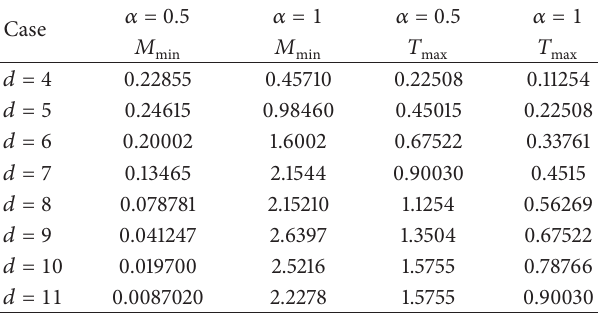
Table 1: GUP ∗ -corrected maximum temperature and minimum mass of TeV black hole for different values of parameter 𝛼 in scenarios with large extra dimensions. Mass is in unit of the Planck mass and temperature is in unit of the Planck energy (supposing = 1 𝑀 𝑝